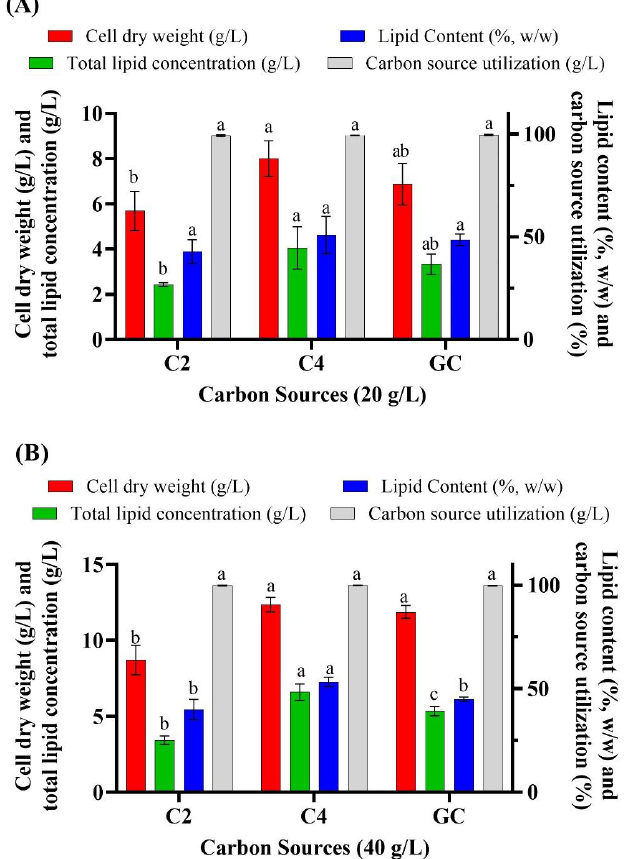
Figure 2. Batch cultivation of Aurantiochytrium sp. T66 on acetic acid (C2) and butyric acid (C4) at 20 g / L ( A ) and 40 g / L ( B ). Glucose (GC) was used as control. Error bars express the standard deviation of the mean Error bars express the standard deviation of the mean ( n = 3). Different letters (a,b,c) above the bars in each group of results indicate significant difference ( p < 0.05), based on one-way ANOVA with Tukey’s test.